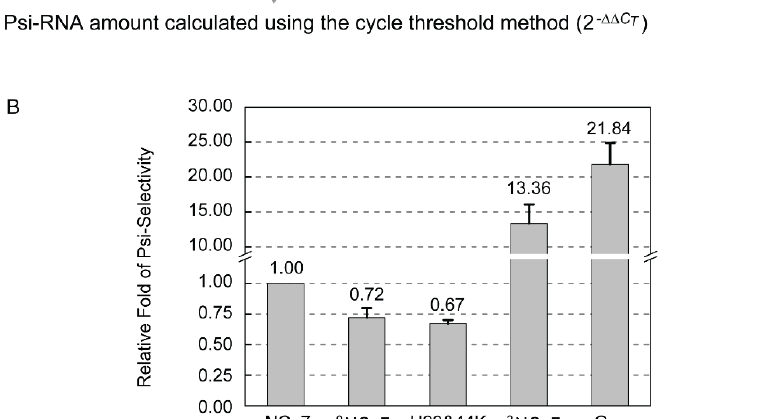
Figure 2. Comparison of 0 NCp7, NCp7 and 2 NCp7 in the Psi-selectivity. ( A ) Schematic representation of the approach to quantifying the Psi-RNA selected by 0 NCp7, NCp7 and 2 NCp7 from in vitro binding reactions. ( B ) The Psi-selectivity of 0 NCp7, NCp7 and 2 NCp7. The data are means and standard deviations from three independent experiments.